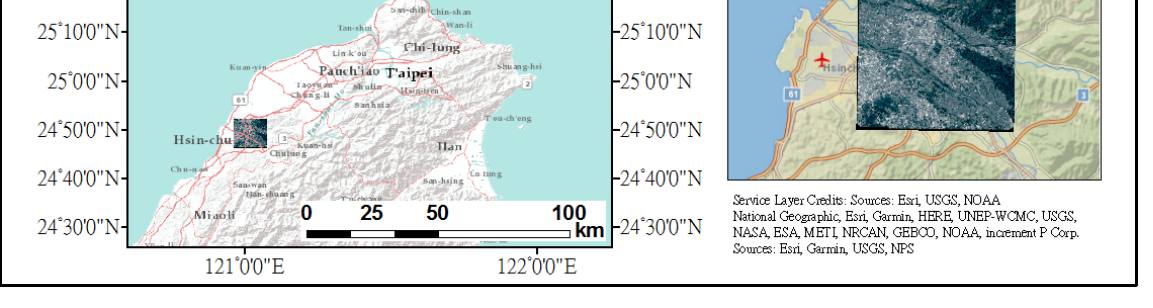
Figure 1. Area covered by VHR satellite imagery. The study area is located in the north-west part of the island. Pleiades VHR satellite imagery capture parts of the city and county of Hsinchu (figure 1). One Pleiades image can cover 122.091 square km. The dataset: consist of three images (tri- stereo) (table 2). The city of Hsinchu is characterized by water streams, buildings and a dense street network. The urban area is in the east surrounded by a chain of hills and in the west by the sea.